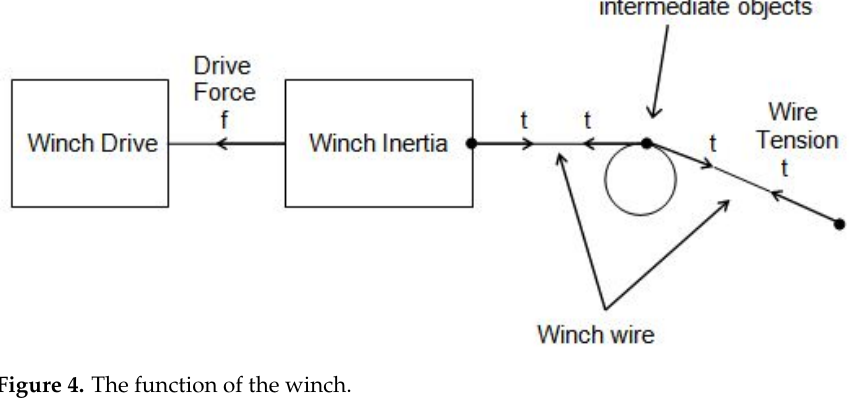
Figure 4. The function of the winch.